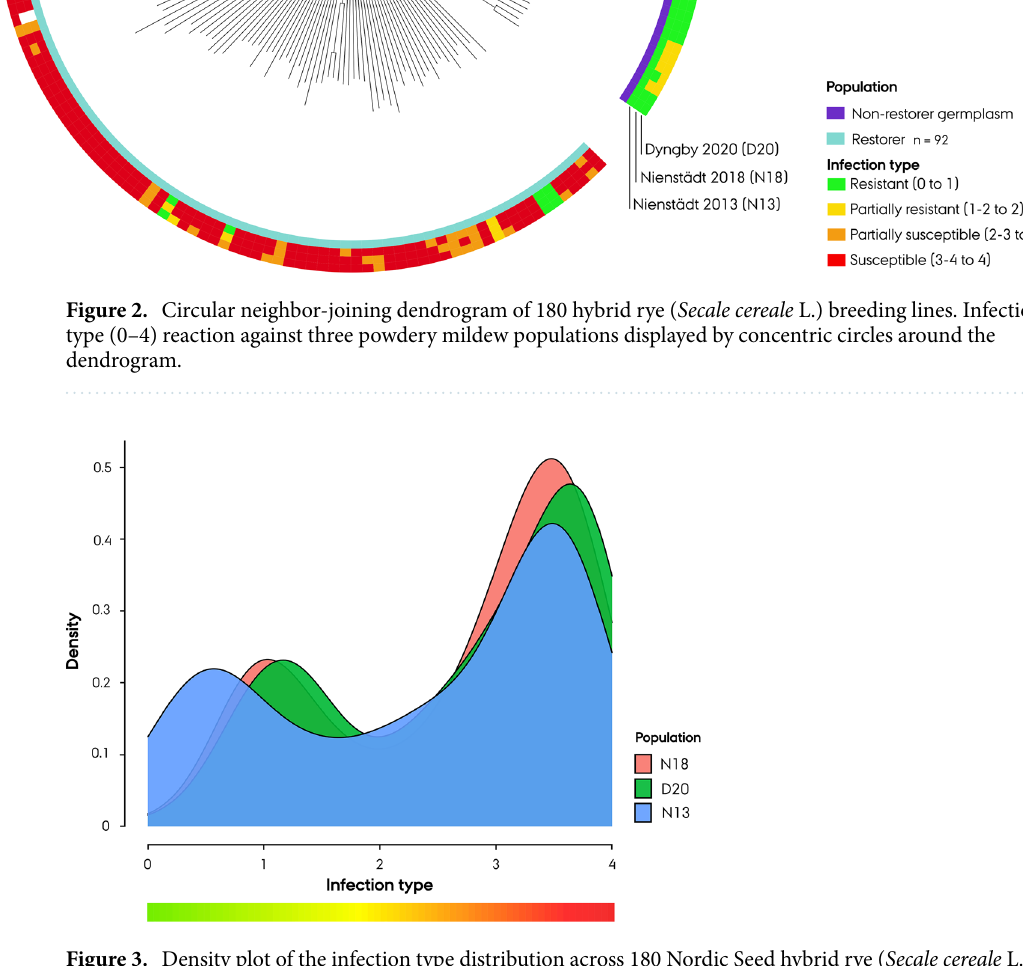
Figure 3. Density plot of the infection type distribution across 180 Nordic Seed hybrid rye ( Secale cereale L.) breeding lines against three powdery mildew